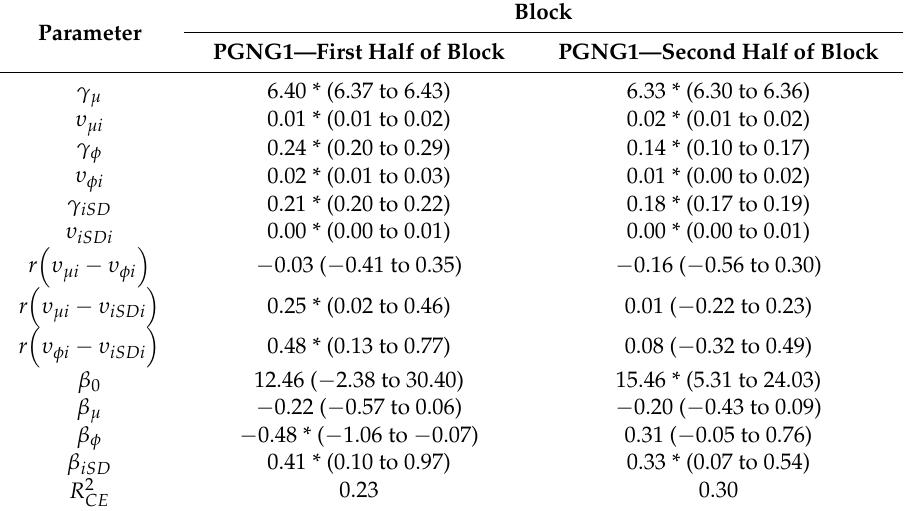
Table A3. Posterior means (and 95% credible intervals) of fixed effects, random effect variances, correlations between random effects, intercepts, and regression weights of CE i on µ i , iSD i , and φ i estimated for the first and second half of PGNG1 trials. Mean fixed effects and random variances are shown in raw metrics, while correlations and regression weights are shown in within-level standardized